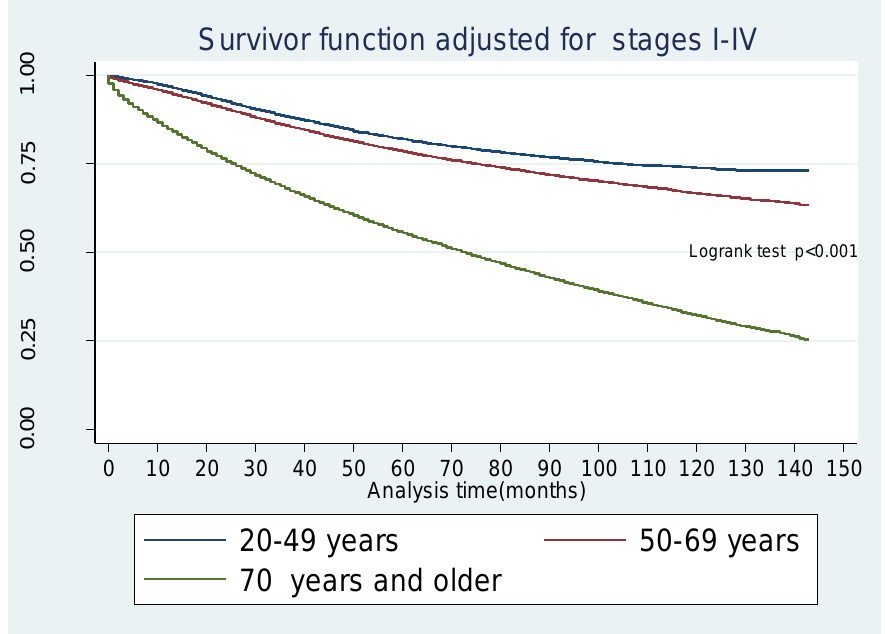
Figure 3. Kaplan Meier Survivor function for overall survival for age group adjusted for colorectal cancer stages. Colorectal cancer (CRC) stages and distribution by age group. Stage1, stage 2, stage 3, and stage 4 represent cancer stages at diagnosis. 20–49 = young age group 20 to 49, 50–69 = middle age group 50 to 69 and 70+ = 70 years and older. Stage 1 = stage I, Stage 2 = stage II, Stage 3 = stage III, Stage 4 = stage IV, I–IV = CRC stages I to IV.